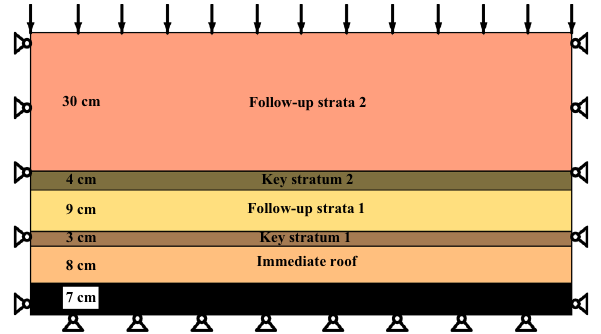
Figure 2. Simplified experimental model.